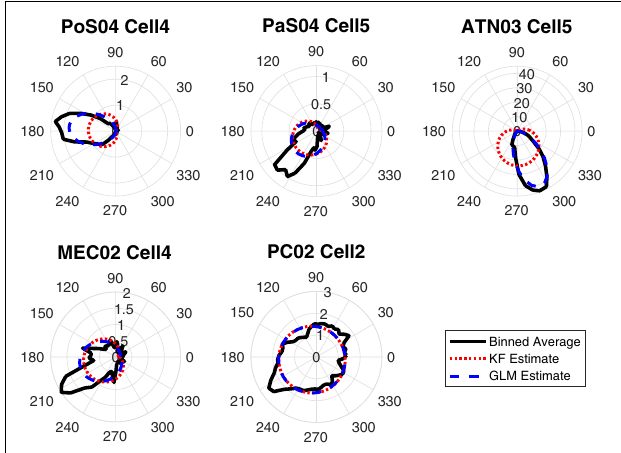
FIGURE 5 | The true-vs.-estimated tuning plots in 6-degree bins for one HD cell in each brain region: The polar plots show firing rates vs. HD. The black curves are the true tuning functions, smoothed by a Gaussian kernel function. The red curves are the estimated functions using the Kalman Filter (KF) method and the blue curves are the estimated functions using the Generalized Linear Model (GLM)